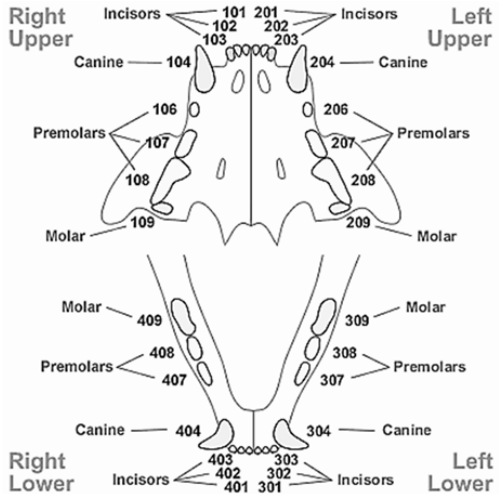
Figure 1. The TRIDAN modified system for cat teeth classification. Adapted from Crossley [12].